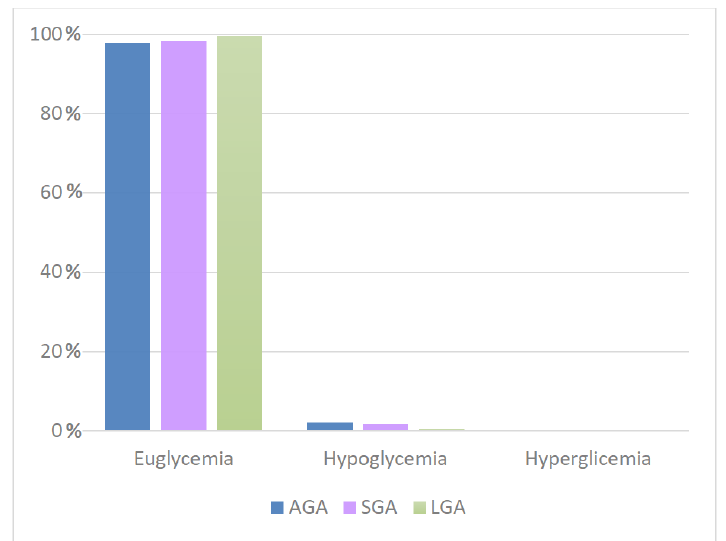
Antioxidants 2022 , 11 , x FOR PEER REVIEW 10 of 17 Figure 6. Correlation between glycemia and weight for gestational age in intermittent feeding. AGA, appropriate for gestational age; SGA, small for gestational age; LGA, large for gestational age.